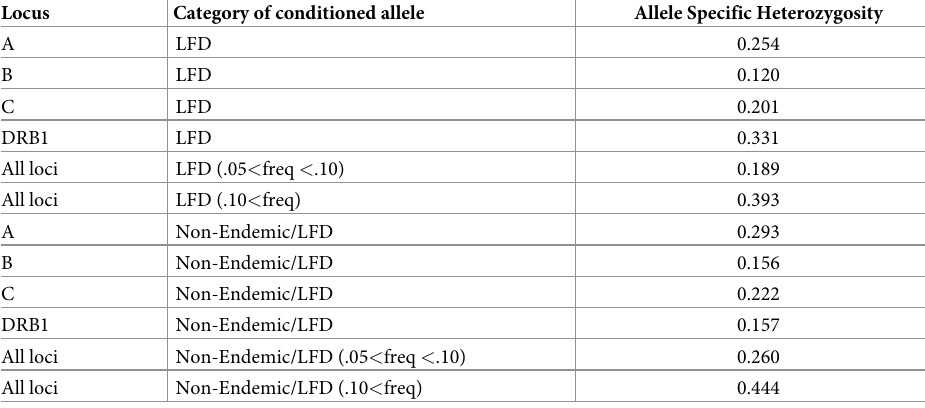
Allele Specific Heterozygosity is the heterozygosity of alleles found in haplotypes with the allele that has been conditioned on. Values were averaged over all alleles of that type for each pair of